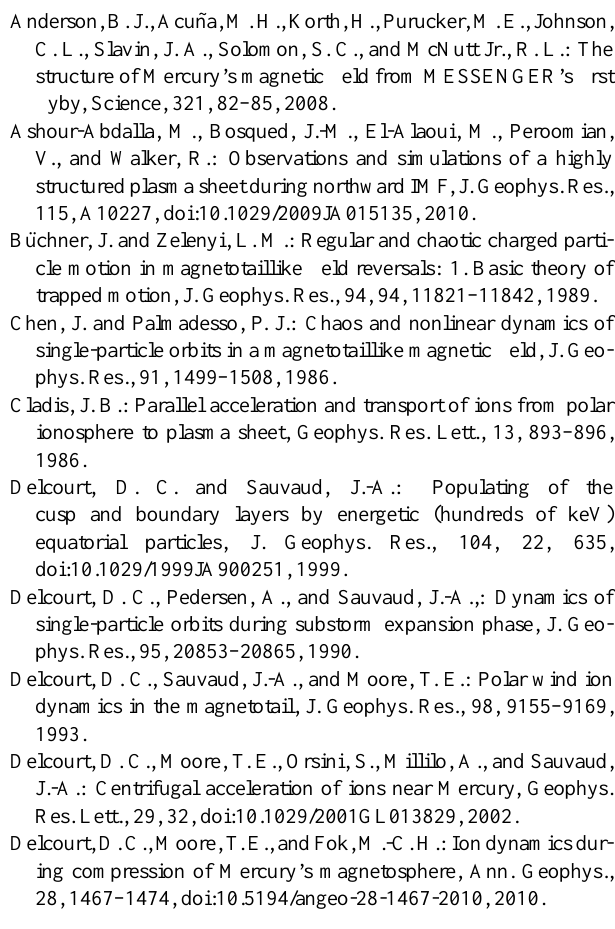
Fig. 12. Model Na + trajectory from polar exosphere to high- latitude magnetospheric lobe via nightside plasma sheet: (left) tra- jectory projections in the noon-midnight meridian plane and in the equatorial plane, (right) energy and magnetic moment (normalized to the initial value) as a function of time. In the bottom left panel, the thick line and shaded area show the magnetopause and the re- gion of cuspward mirror force,